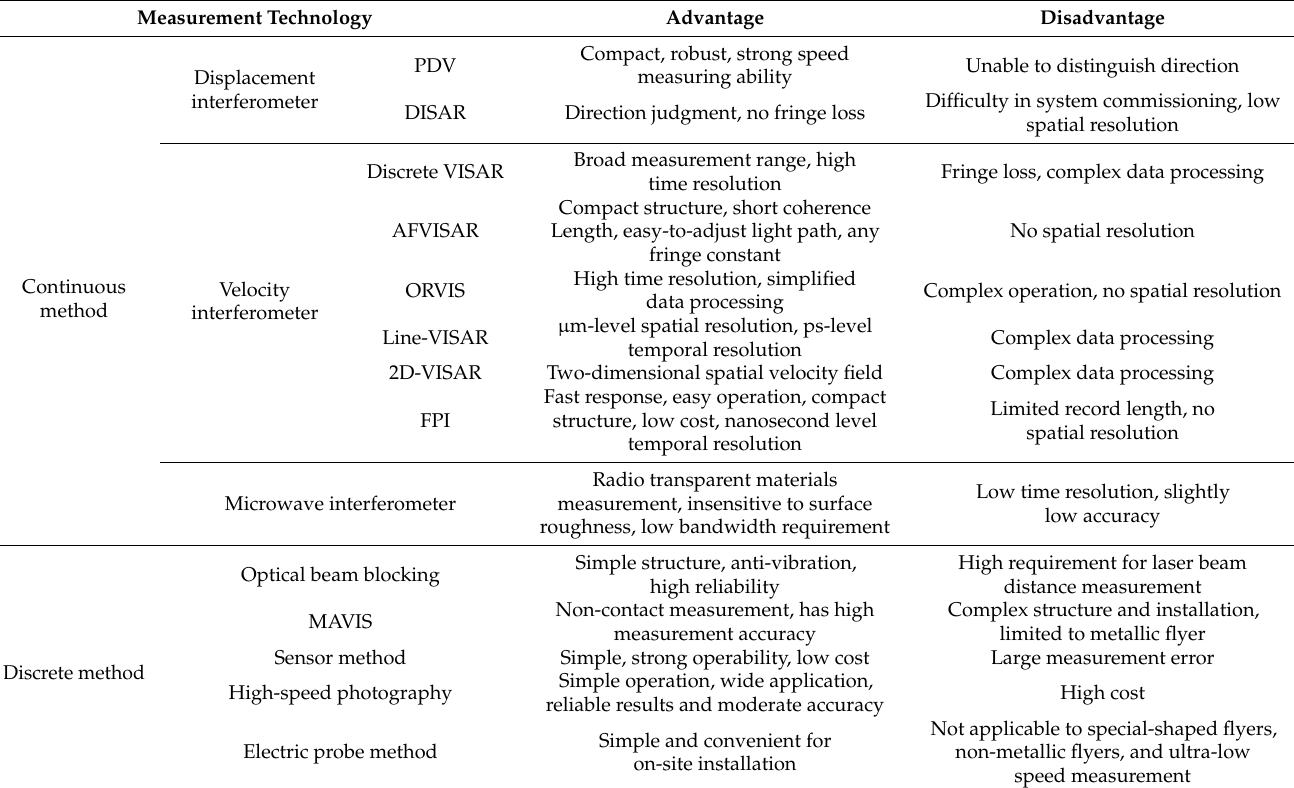
Table 2. Comparison of different velocity measurement